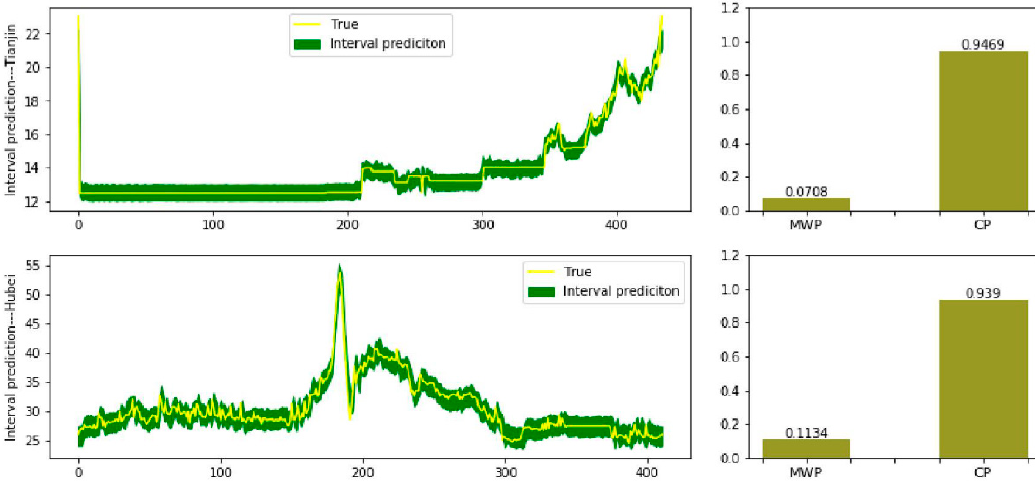
Figure 8. The interval prediction estimate of two cases.